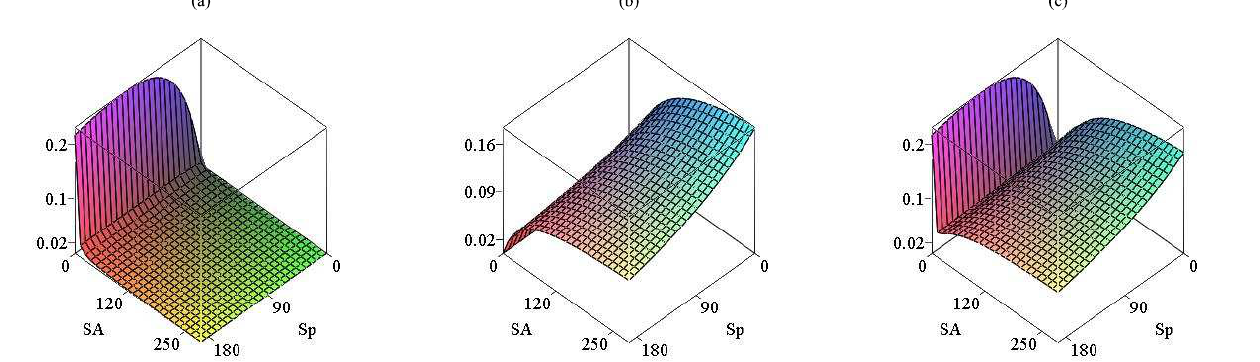
Figure 1. Graphs of the specific growth rates: ( a ) µ P ( S P , S A ) , ( b ) µ A ( S P , S A ) and ( c ) µ P ( S P , S A ) + µ A ( S P , S A ) for S P ∈ [ 0, S 0